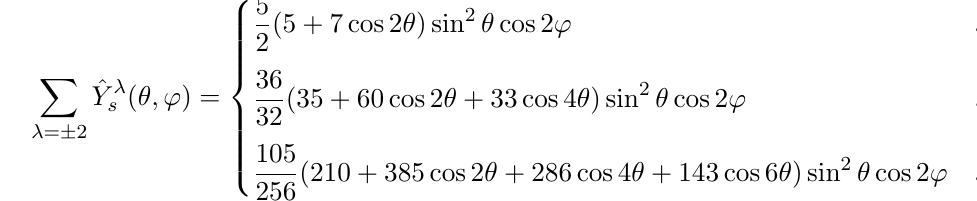
Figure 3 . Angular dependence ^ Y 2 massless (cid:12)eld as a function of the angle (cid:18) = cos (cid:0) 1 (^ k 1 correspond to spins 4, 6, and 8,